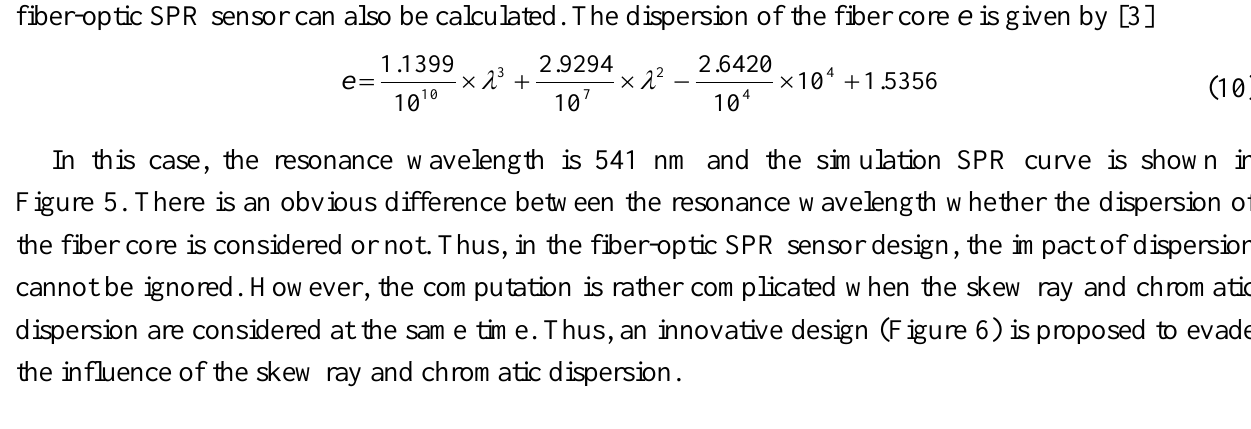
Figure 5. Simulation spectrum of the fiber-optic SPR sensor when the chromatic dispersion of the fiber core is